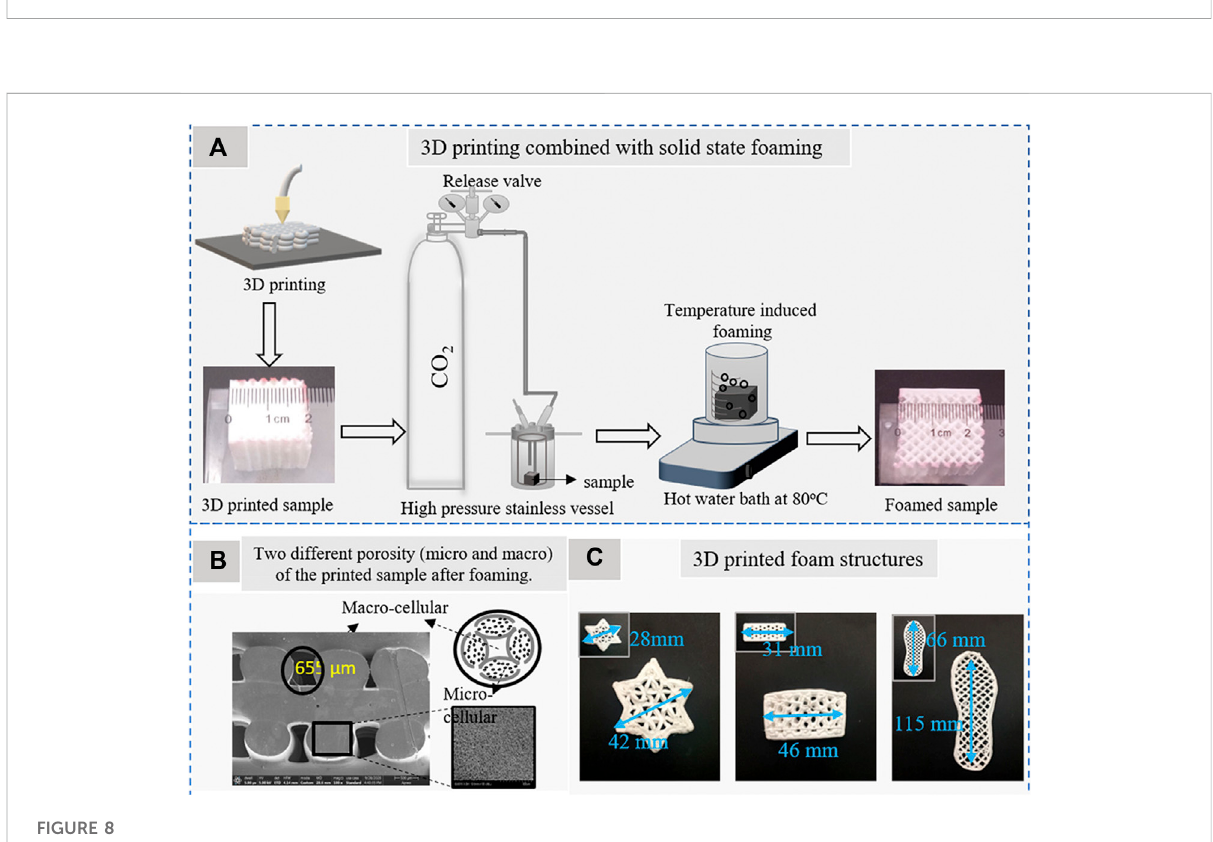
FIGURE 8 (A) Schematicpresentationofthe3DprintingcombinedCO 2 solid-statefoamingprocess. (B) Twodifferentporositiesoftheprintedsample. (C) 3D printed foamed sample with different structures. Copyright 2022, American Chemical